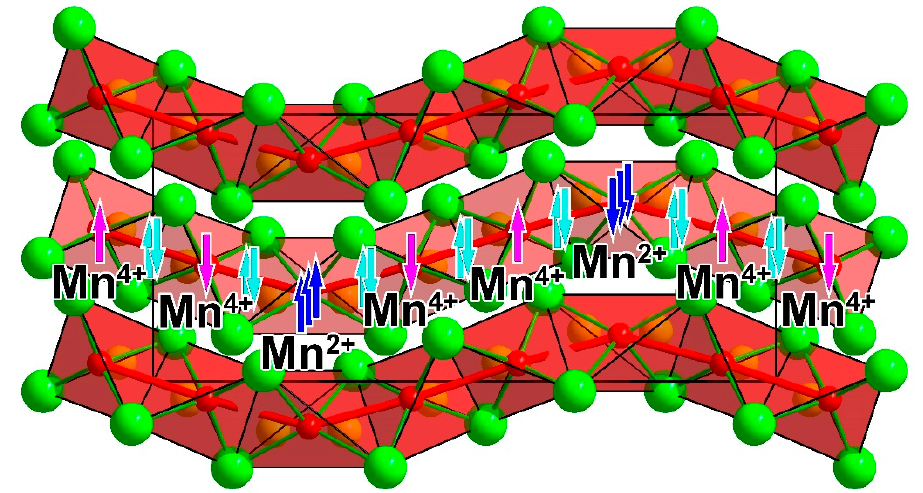
Figure 8. Schematic representation of the possible valence d -electron distribution along the chains in Ba 4 [Mn 3 N 6 ]. Unpaired electrons on Mn 2+ and Mn 4+ are shown in blue and pink, respectively. Electron pairs representing Mn–Mn bonds are shown in cyan.